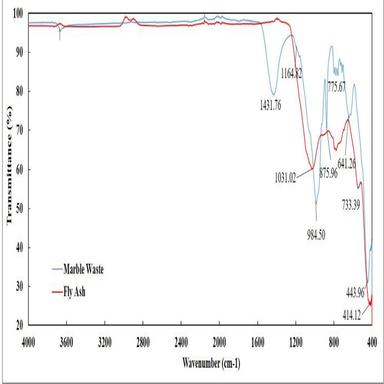
FTIR spectra of fly ash and marble waste.